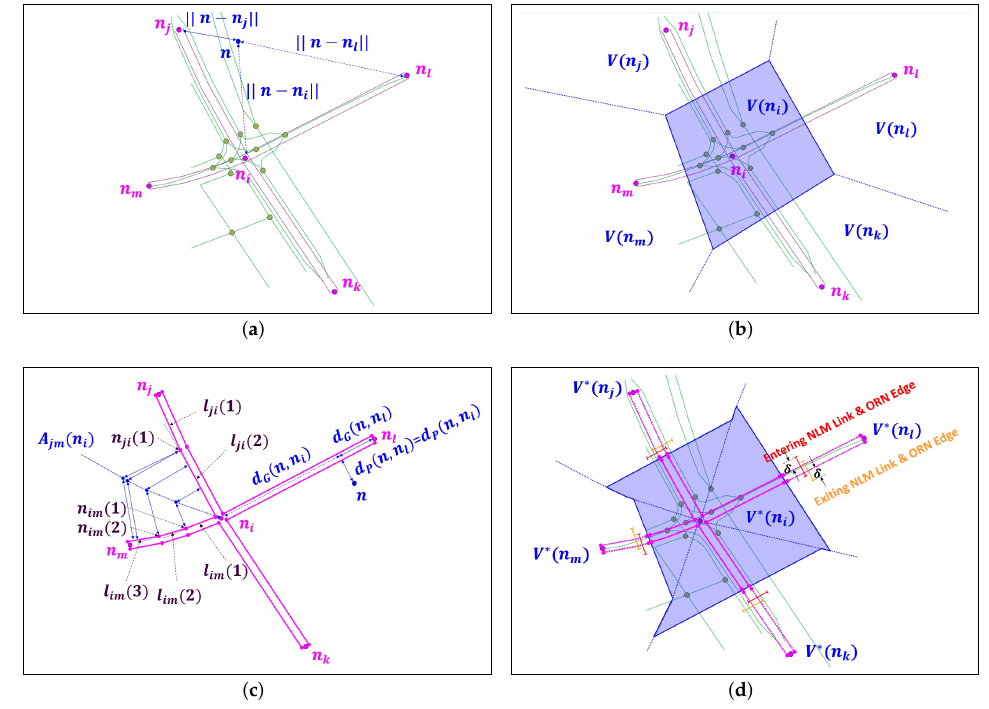
Figure 5. VD and NVAD to partition map area A ( n i ) around NLM node n i : ( a ) Euclidean distance of Voronoi diagram, ( b ) Voronoi cell V ( n i ) for NLM node n i , ( c ) distance metrics and projection boundary of NVAD, and ( d ) NVAD V ∗ ( n i ) for NLM node n i